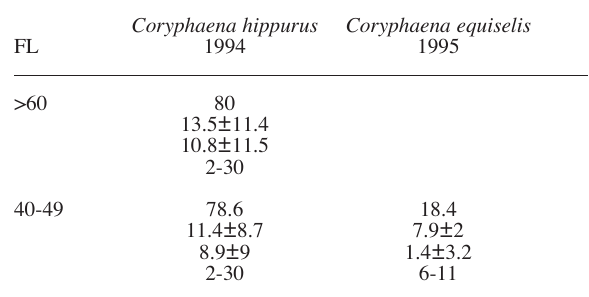
Table 5. – Infestation paraeters of the copepod species uryphorus nymph of Coryphaena hippurus and Coryphaena equiselis captured in Atlantic waters (FL: fork length in cm; first row: prevalence; sec- ond row: mean intensity ± SD; third row: mean abundance ± SD; fourth row: